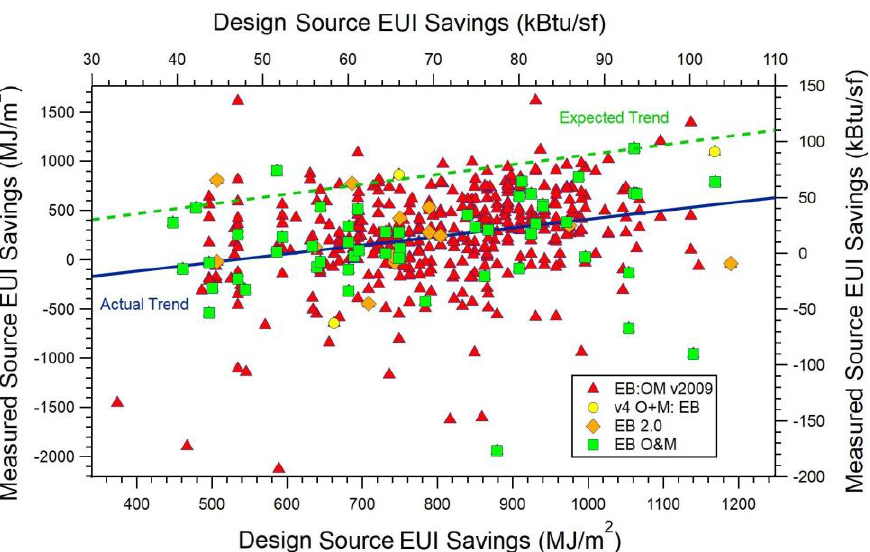
Figure 5. Comparison of the 2016 source energy savings ( δ SourceEUI) vs. that projected from energy efficiency points (EAc1) for 454 LEED offices certified under LEED-EB (Existing Buildings). The blue line is the actual trend line, while the dashed green line represents the expected trend (measured = predicted).